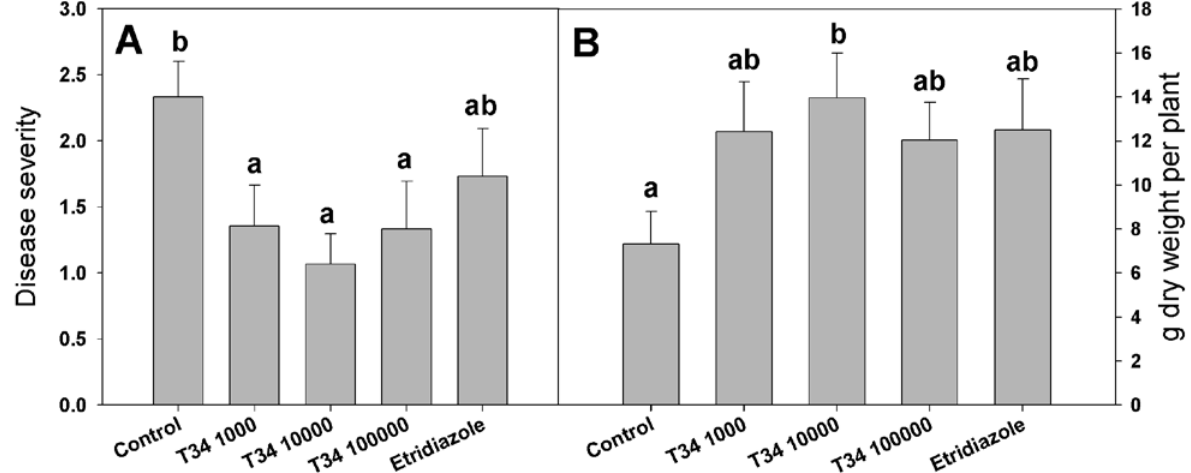
Figure 2 . Disease severity produced by Phytophthora capsici in pepper plants (A) and dry weight of the pepper plants (B) on the last day of the 2009 greenhouse experiment (45 d after inoculation with the pathogen). Disease severity was scored us- ing the following symptom scale: 0, healthy plant; 1, small canker (less than 2.5 cm); 2, medium canker (2.5–5 cm); 3, large canker (more than 5 cm); and 4, dead plants. Control, water; T34 1,000, 10,000 and 100,000, Trichoderma asperellum strain T34 at 10 3 , 10 4 and 10 5 conidia mL -1 ; Etridiazole, Terrazole ® at 2 L ha -1 . Treatments were applied 30 d before inoculation with the pathogen and a second treatment was applied upon detection of symptoms of disease. Different letters indicate significant differences within treatments, Duncan’s multiple range test ( P <0.05).